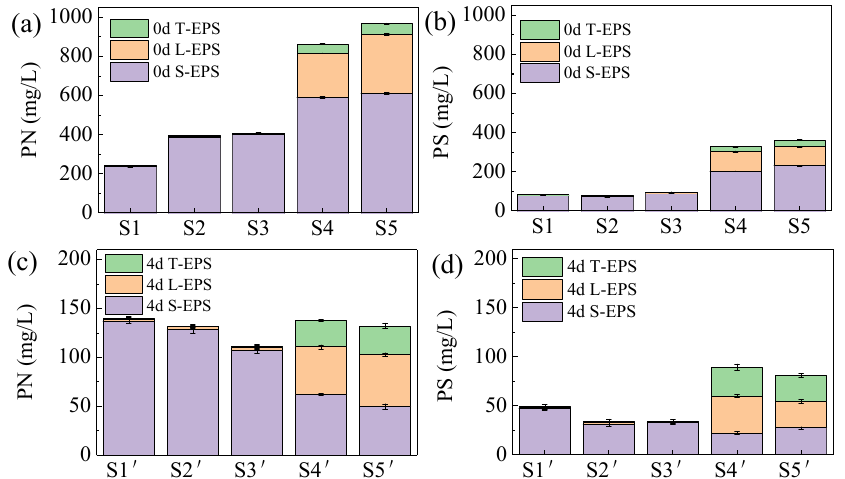
Figure 1. Changes in EPS in the liquid phase after ferrate pretreatment and digestion (( a ) PN concentration after pretreatment, ( b ) PS concentration after pretreatment, ( c ) PN concentration after digestion, and ( d ) PS concentration after digestion).